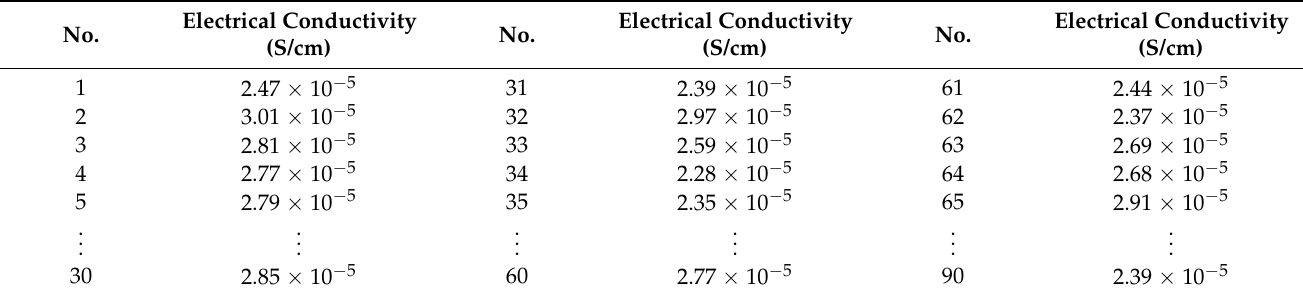
Table 6. Results of the electrical conductivity test for Case